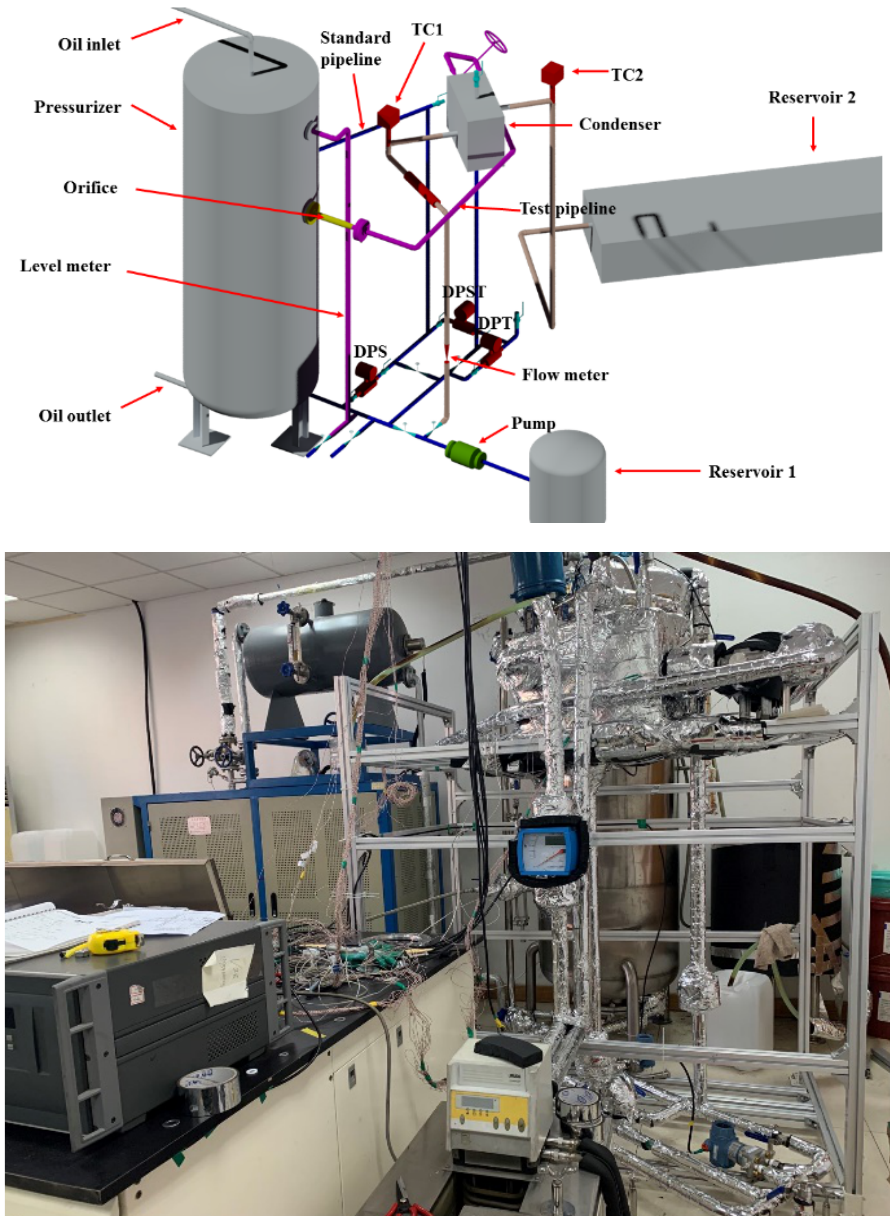
Figure 3. Experimental system.